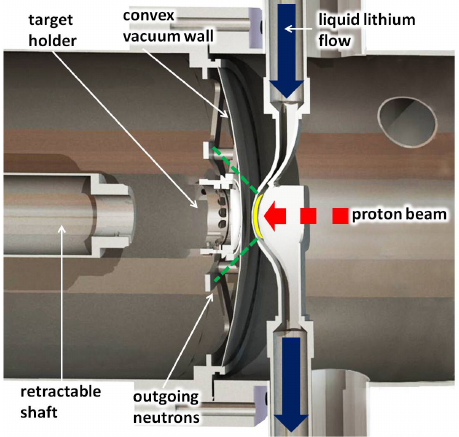
Figure 4. Diagram of the Liquid-Lithium Target (LiLiT) and ac- tivation target assembly. The (1-2 mA, ≈ 9 mm full width) proton beam (dashed red arrow) impinges on the free-surface lithium film (yellow crescent). The solid blue arrows show the inlet and outlet of the external circulating loop (see [7] for details). The ac- tivation targets are mounted on a circular holder and positioned in the outgoing neutron cone (green dotted lines) at a distance of ≈ 6 mm from the lithium surface in a vacuum chamber separated from the LiLiT chamber by a 0.5 mm stainless steel wall convex to the beam. The retractable shaft (at left) is used to load and unload rapidly the target assembly. The shaft is removed before the irradiation. Adapted from [11].